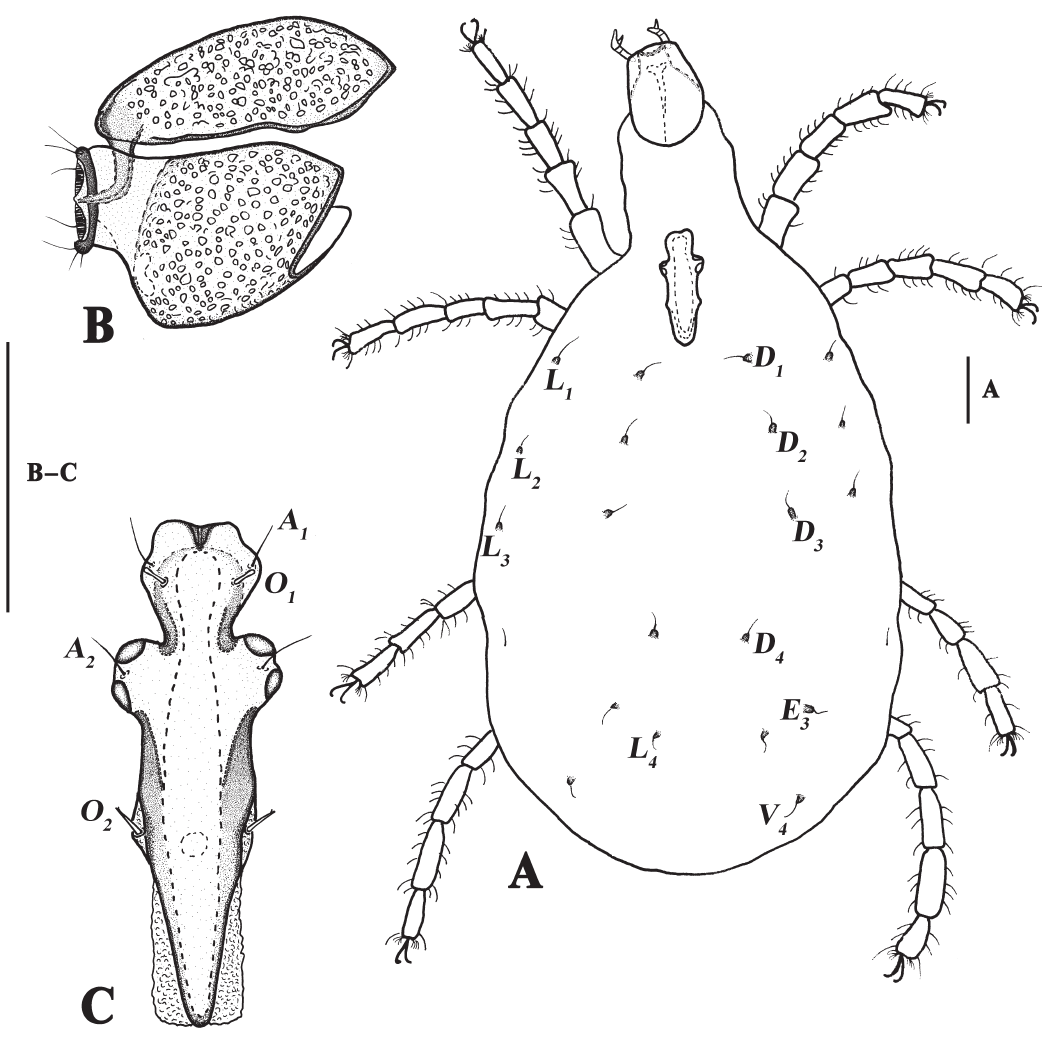
Fig. 7. Pentachares sinensis Li & Guo gen. et sp. nov., holotype, ♀ (GUGC GD-LI-20190801). A . Idiosoma, dorsal view. B . Gnathosoma. C . Frontal plate. Scale bars = 200